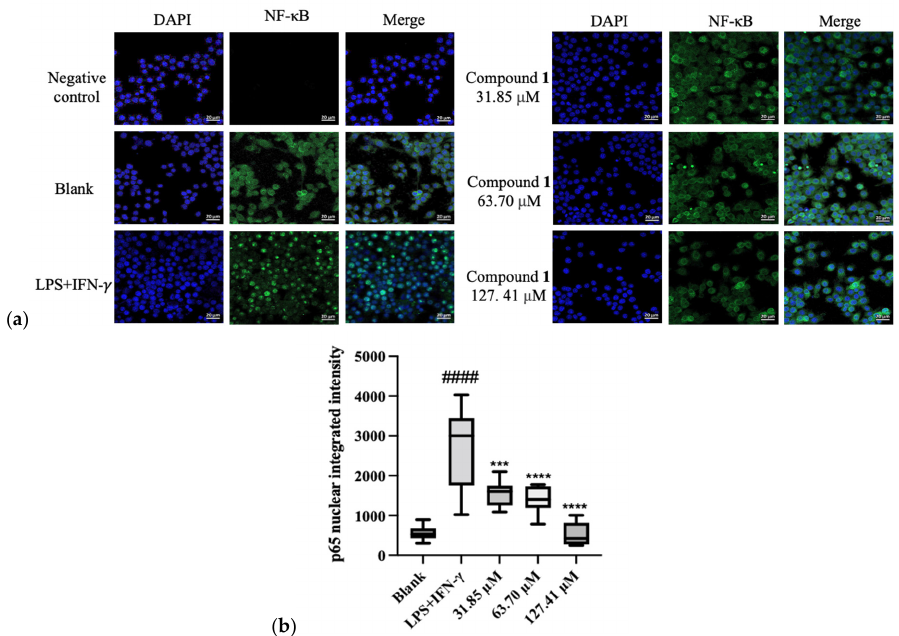
Figure 4. ( a ) RAW 264.7 cells were pre-treated with media (blank), compound 1 for 2 h, then stimulated with LPS and IFN- γ for 30 min. The cells were fixed and subjected to fluorescence staining with the mouse anti-p65 NF- κ B antibody and Alexa Fluor 488 (green dye). The nuclei were stained with DAPI blue. Negative control refers to the RAW 264.7 cells with media, but not exposed to the mouse anti-p65 NF- κ B antibody, and thus, not expressing the target antigen. The translocation of NF- κ B (p65) was determined by using the immunofluorescence assay. Representative images were taken by confocal microscope with 40X magnification (scale bar = 20 µ m). Blue: DAPI in the nucleus, green: NF- κ B in the RAW 264.7 cells. ( b ) Quantification of % of nuclei positive p65 of staining in blank, LPS and IFN- γ -stimulated macrophages with and without various